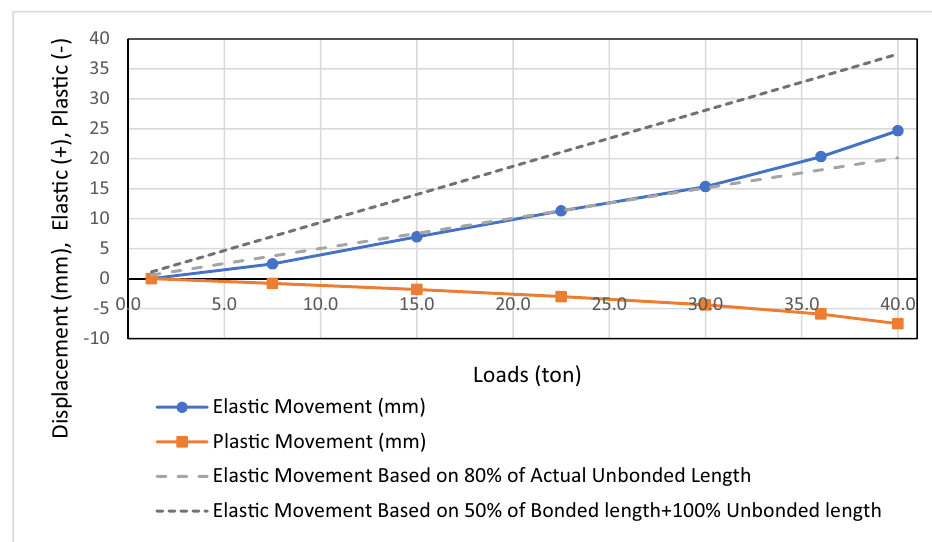
Figure 13: Load – elastic and plastic displacements for anchor 2.